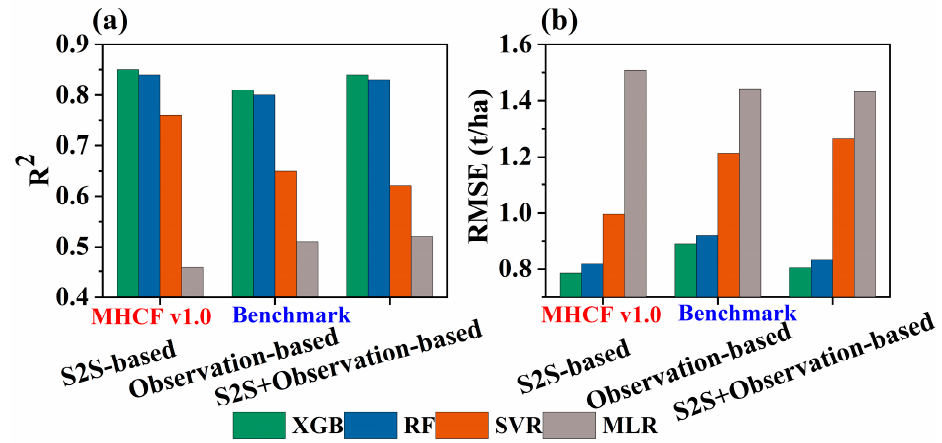
Figure 3. Model performance of the three groups of variables. ( a ) the prediction R 2 of the four models (XGBoost, RF, SVR, and MLR); ( b ) the RMSE (unit: t/ha) of the predicted yield.